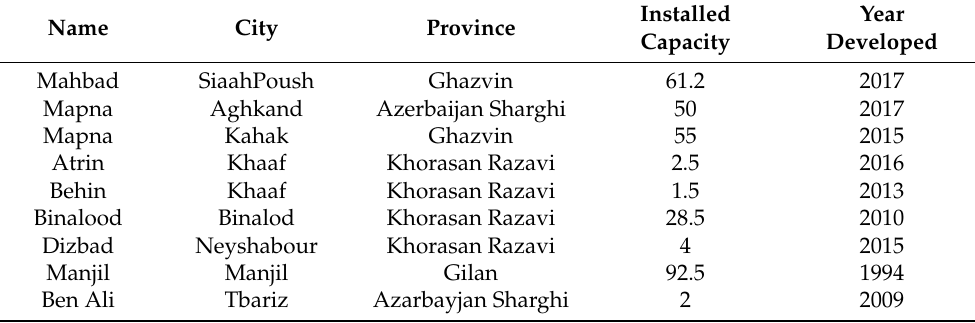
Table 1. Wind farms in